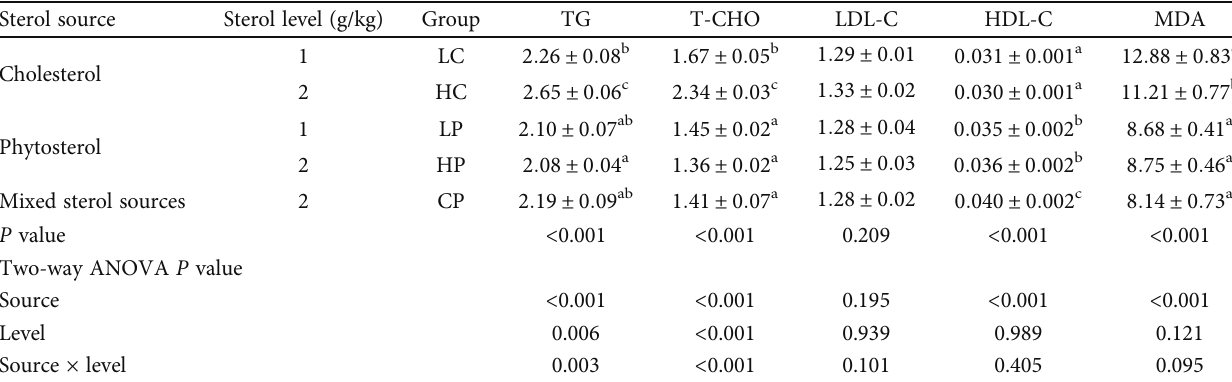
Table 4: Hemolymph biochemical parameters of shrimp fed di ff erent diets.